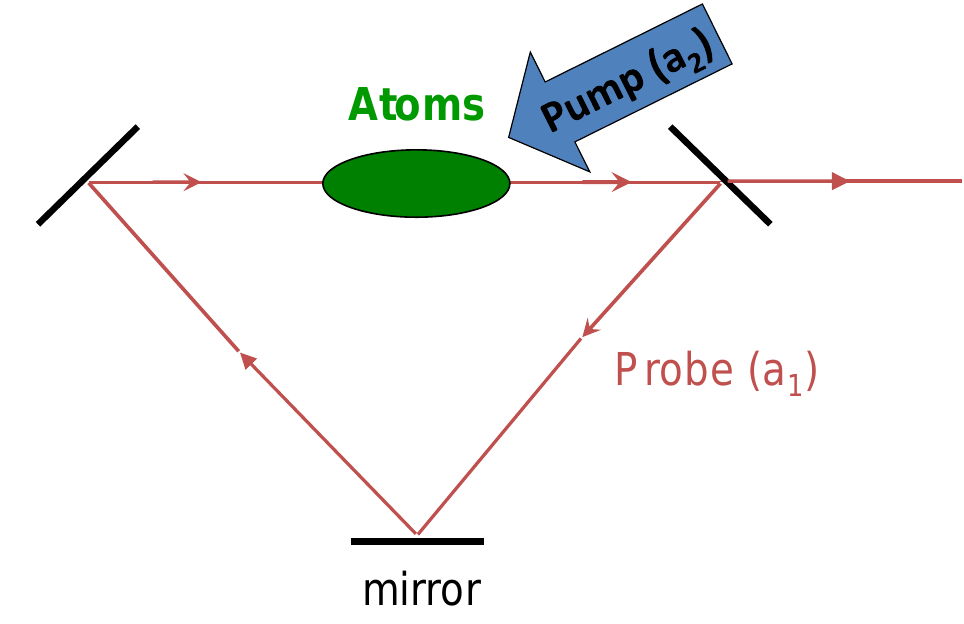
Figure 2. Schematic diagram of the collective atomic recoil lasing (CARL)